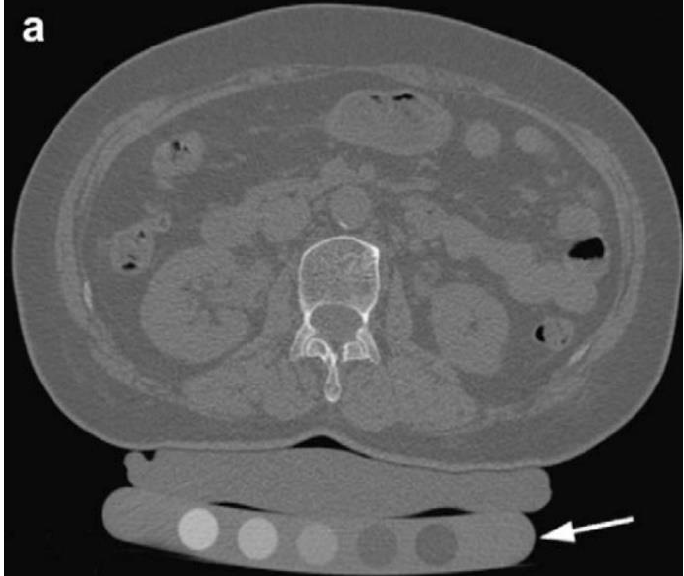
Figure 10. Quantitative computer tomography (QCT) of a vertebral body scanned simultaneously with the calibration phantoms, containing equivalent densities of 0, 50, 100, 150 and 200 mg / cm 3 (reproduced with permission from [12], Elsevier, 2008).